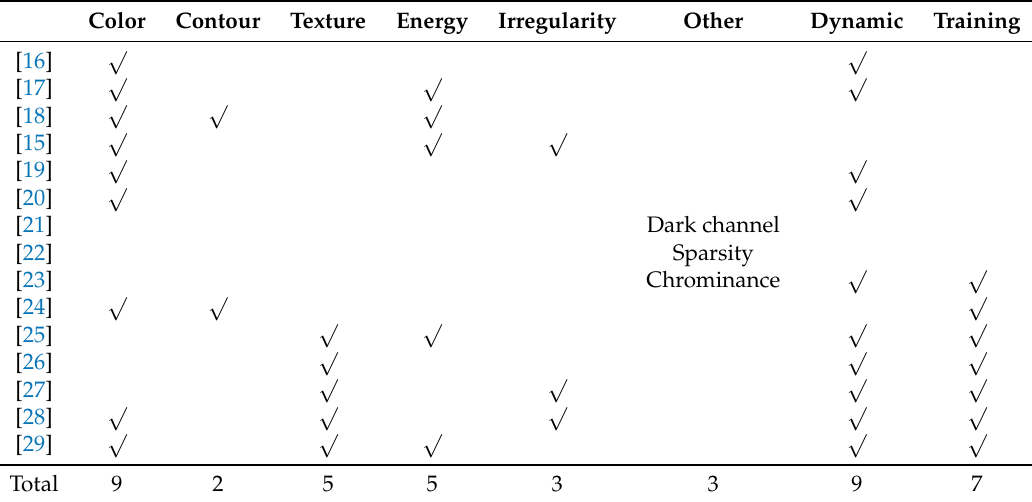
Table 1. Literatures about fire smoke feature